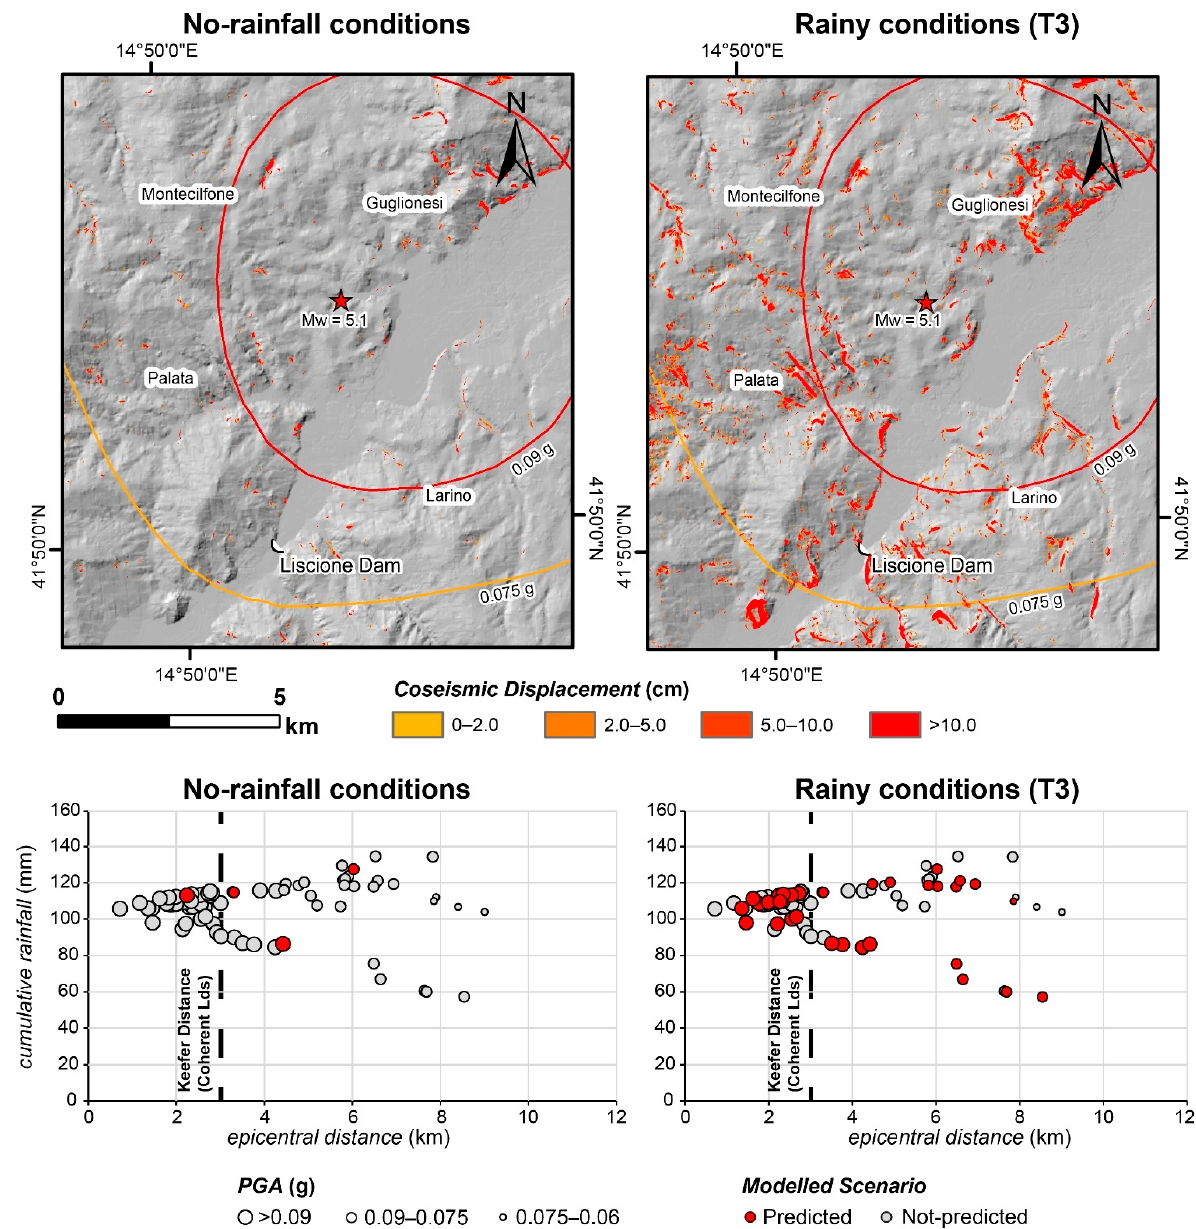
Figure 11. Maps reporting the spatial distribution of the EqTLs predicted by the Newmark’s ap- proach in no-rainfall and rainy conditions, respectively. For the same conditions the graphs report the comparison between the predicted EqTLs in the modelled scenario (red points) and the ones inventoried in the effective scenario of the 2018 Montecilfone earthquake.